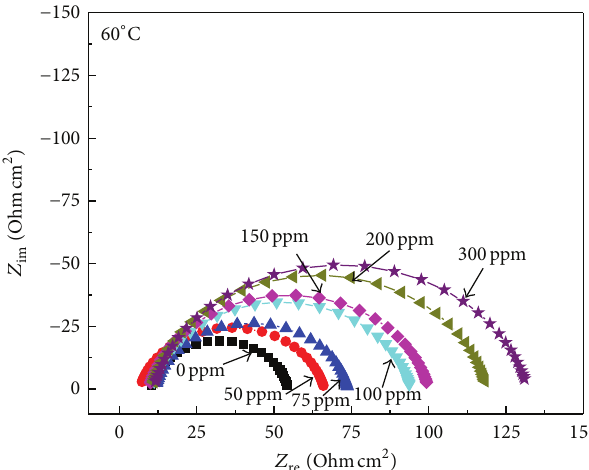
Figure 8: Effect of Opuntia ficus-indica concentration on the Nyquist diagrams for carbon steel in 1M HCl at 60 ∘ C.